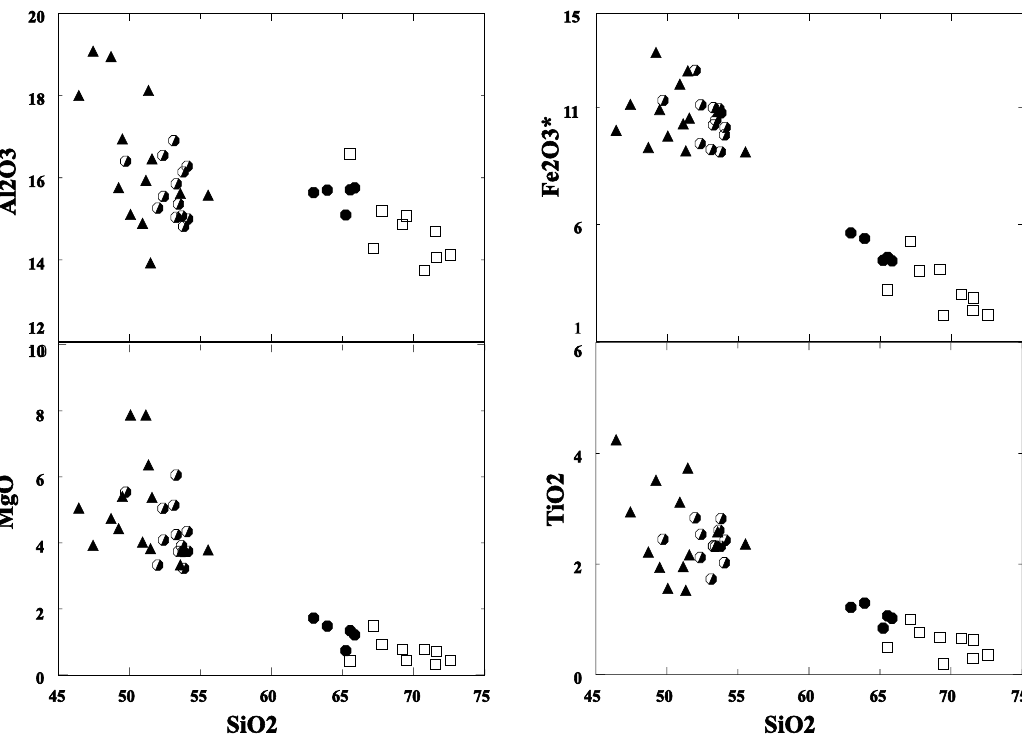
Fig. 2a – Harker diagramas for the rocks of theVAIC. Symbols: (cid:1) Opx-gabbro; ◗ qz-diorites to qz-monzodiorites; (cid:3) sphene qz-syenite; ❒ megagaporphyritic